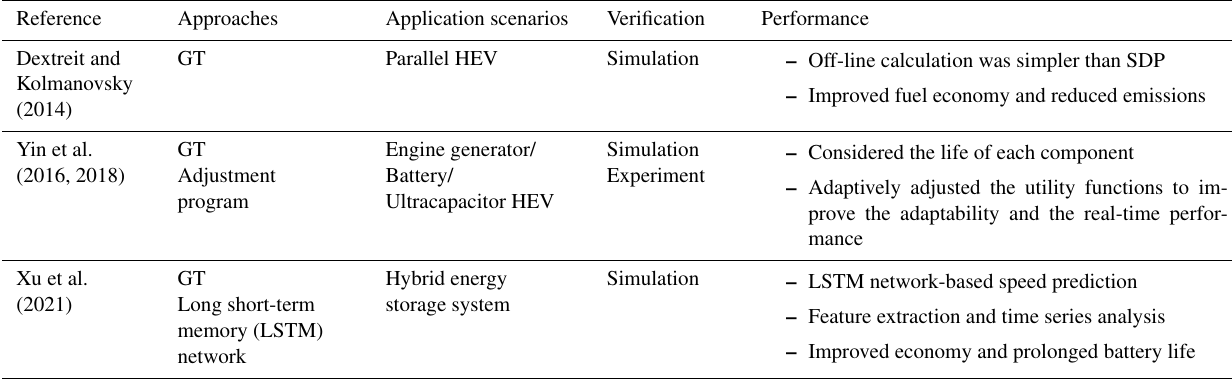
Table 8. Summary of exemplary works on GT-based